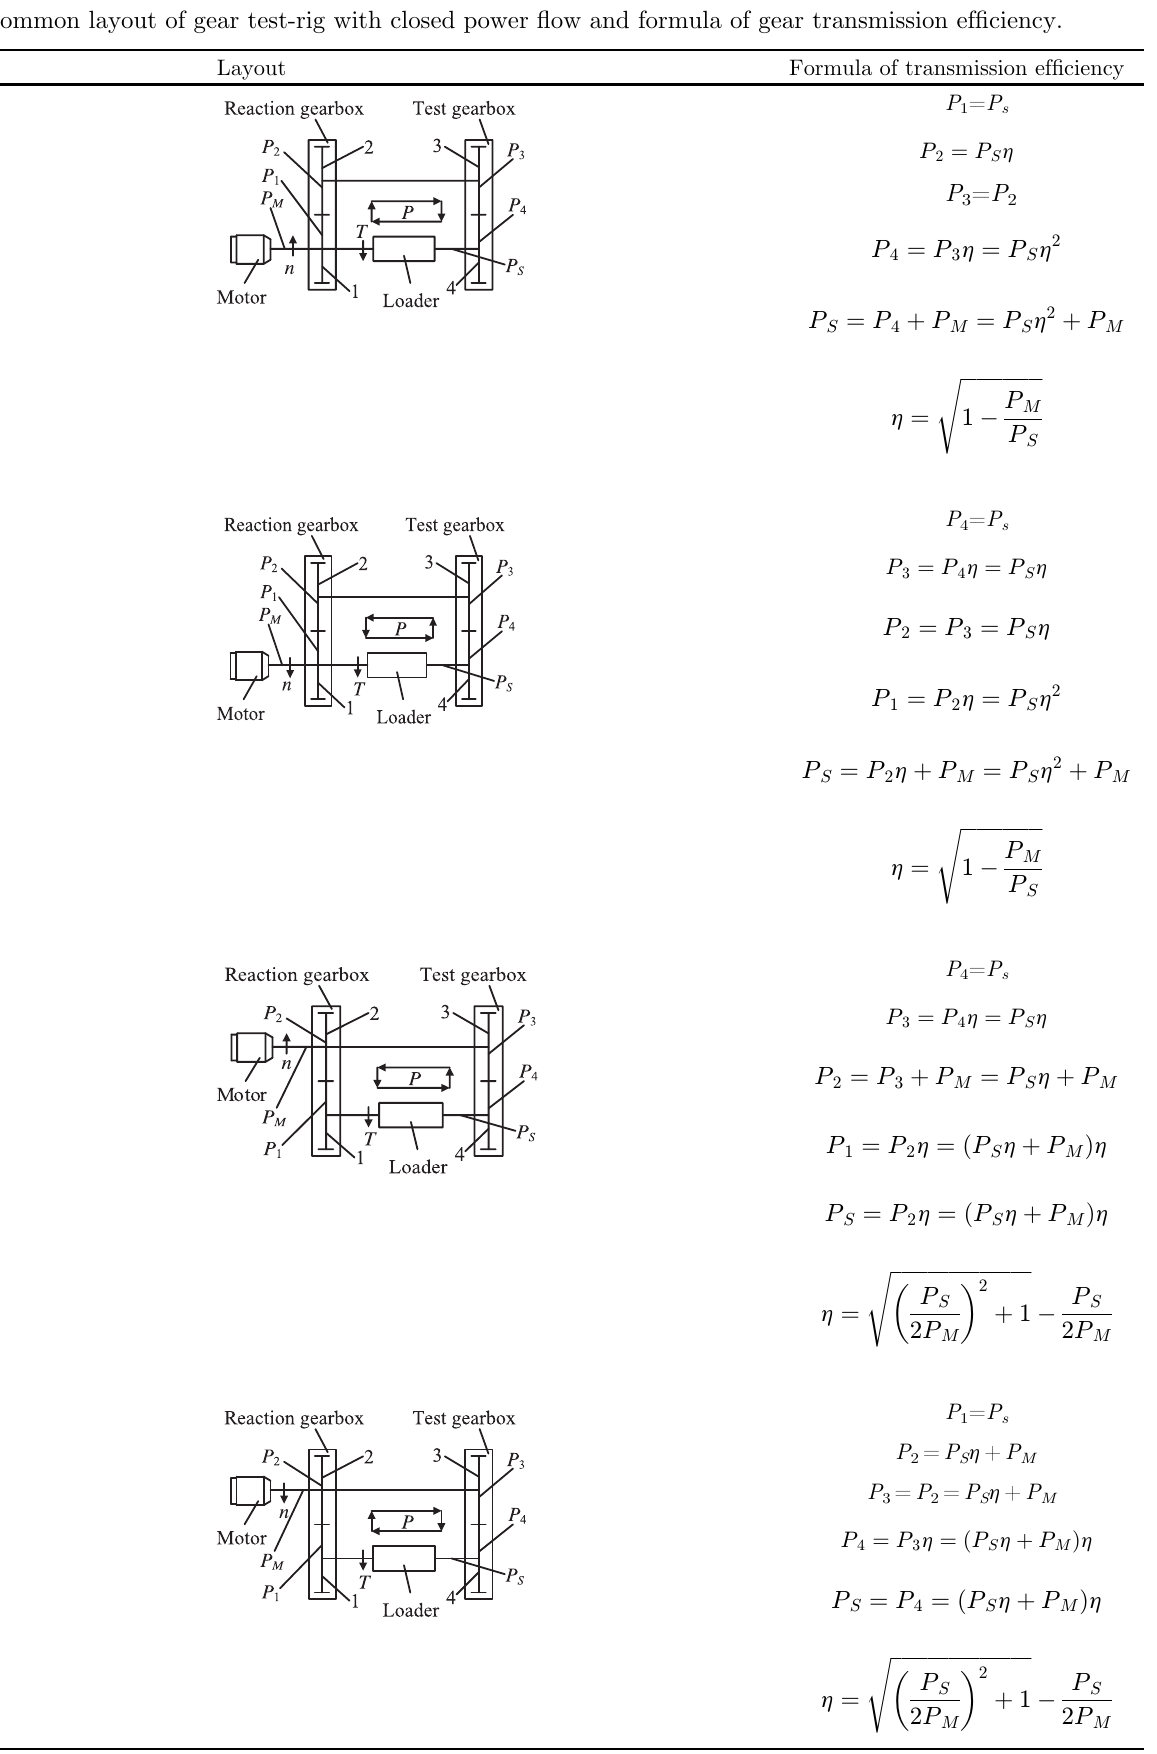
Table 1. Common layout of gear test-rig with closed power fl ow and formula of gear transmission ef fi ciency. Condition